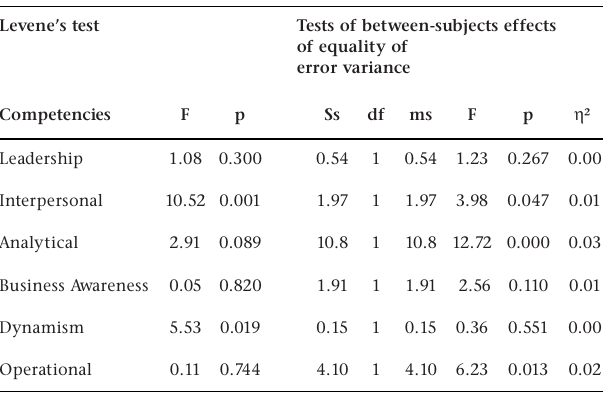
MANOVA SUMMARY TABLE FOR THE PMC